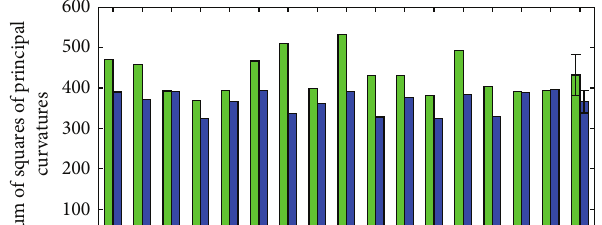
Table 1: Interrater variability is examined by presenting 𝜅 overlap between various pairs of data (indicated in the left column). Case 1 Average LDDMM versus Manual Segs. 0.780 GDAS versus Manual Segs. Manual Segs. LDDMM versus GDAS